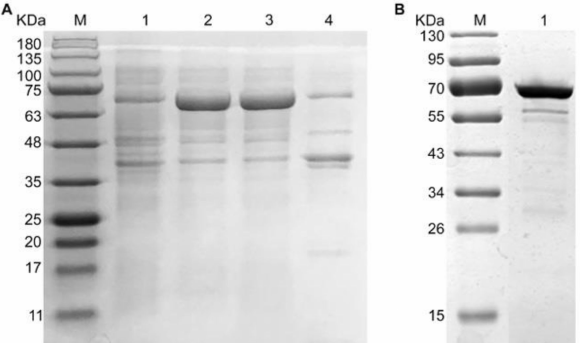
Figure 4. Expression and purification of recombinant NP of SARS-CoV-2 in E. coli . ( A ) Detection of recombinant NP through SDS-PAGE under different conditions. M: marker, 1: before IPTG induction, 2: after isopropyl β - D -1-thiogalactopyranoside (IPTG) induction, 3: supernatant, 4: insoluble fraction. ( B ) Purified recombinant NP. M: marker, 1: purified recombinant